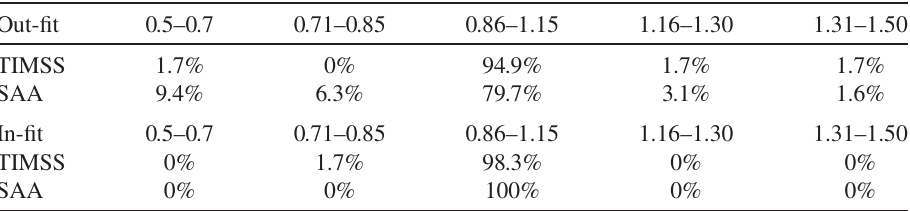
TABLE III. Percent of items through characteristic intervals of out-fit and in-fit values.